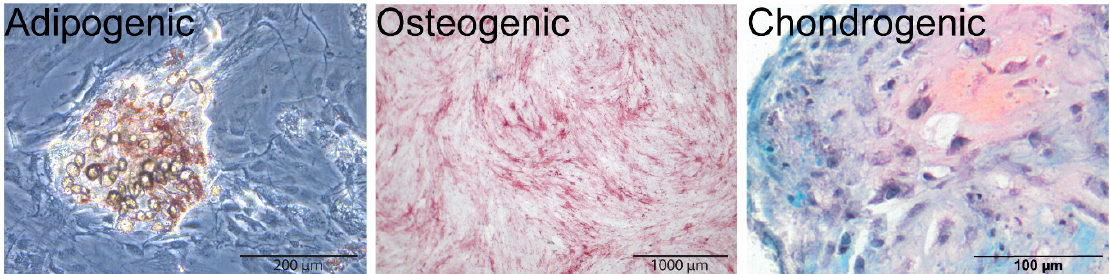
Figure 4. Multipotency assays were performed to ascertain the tri-potency of the human mesenchymal stromal cells (MSCs) used in this study. Red staining by Oil Red O indicated lipid formation after adipogenic di ff erentiation of MSCs. Alkaline phosphatase was stained in pink by fuchsine, indicating that osteogenic di ff erentiation occurred. Chondrogenesis was confirmed by Safranin O staining in pellets.